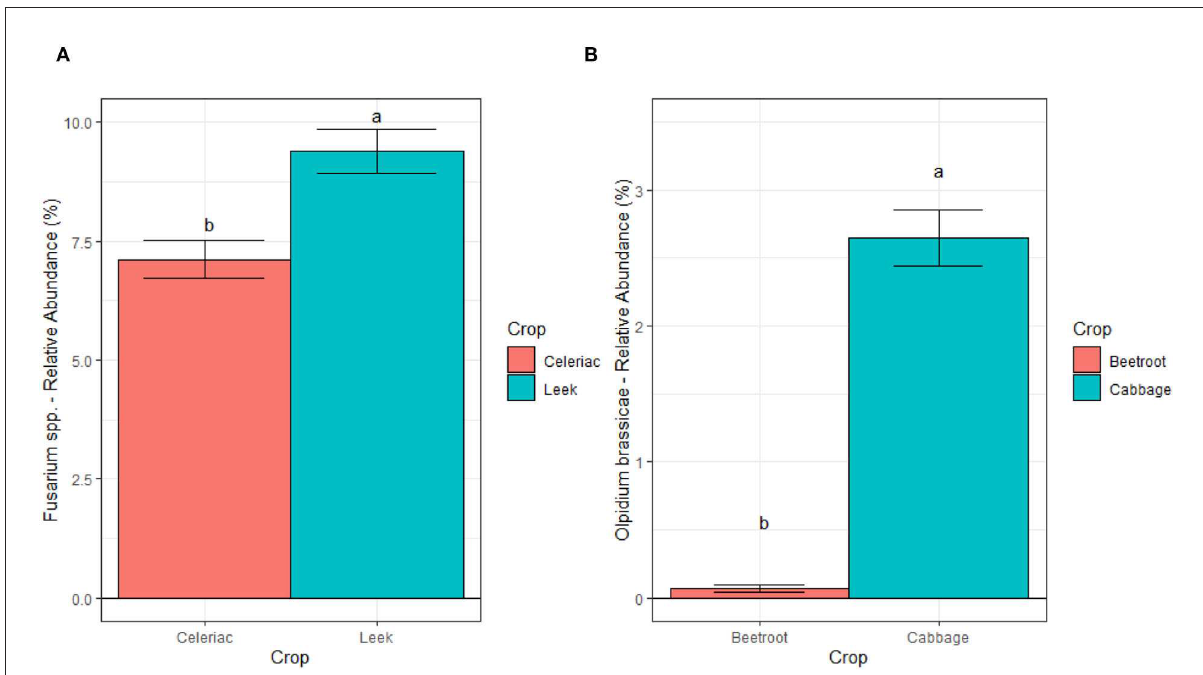
FIGURE8 Relative abundances of Fusarium spp. at ILVO site (A) and of Olpidium Brassicae at AU site (B) , averaged across cropping systems and blocks. Bars denote standard errors of the mean. Different letters are significantly different at p < 0.05 (Tukey test).